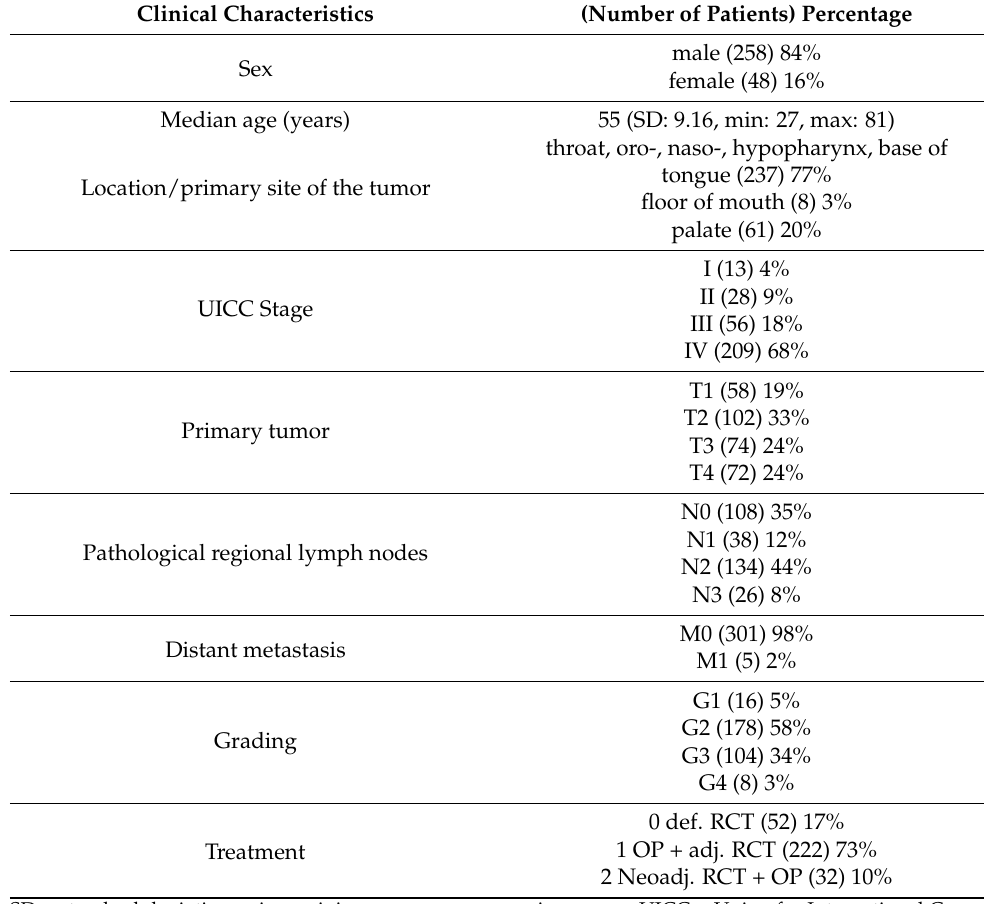
Table 1. Clinical characteristics of the studied patient